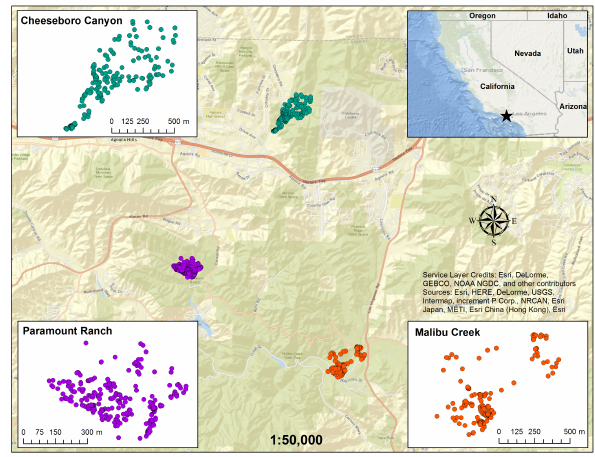
Figure 1. Study area locations and stem distributions. The three sites are public open spaces within a larger valley oak landscape in the Santa Monica Mountains, in southern California, near the southern limit of the species’ geographic range (see inset